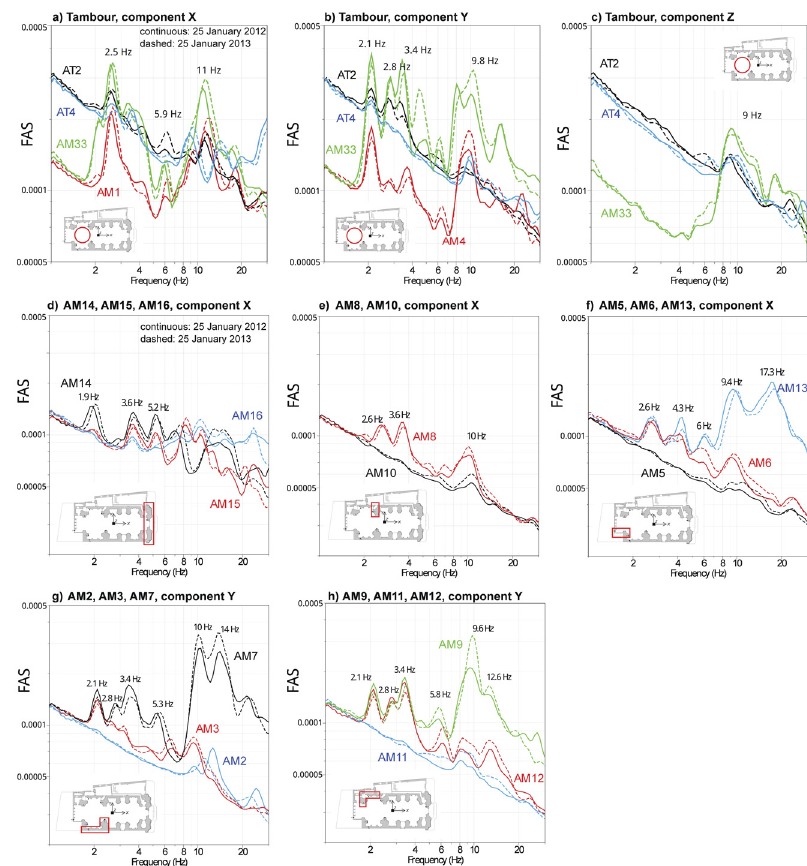
Figure 4. FAS computed on ambient noise data recorded by accelerometers. The time-length of recordings is 1 hour of the 25 January of 2012 and 2013 years (continuous and dashed lines, respectively). The frequency values of the main common spectral peaks are also reported as text into the panels. Units on y-axis are g/Hz. A small drawing of the sub-set of the displayed sensors is reported in each panel. Panels a, b and c refer to accelerometers located on the tambour (X, Y and Z component). Panels d, e, f, g and h refer to accelerometers located in the remaining structural elements (X and Y component in d, e, f and g, h panels, respectively). The response of AT1, placed at -2 m from the ground floor, was not reported because fully dominated by